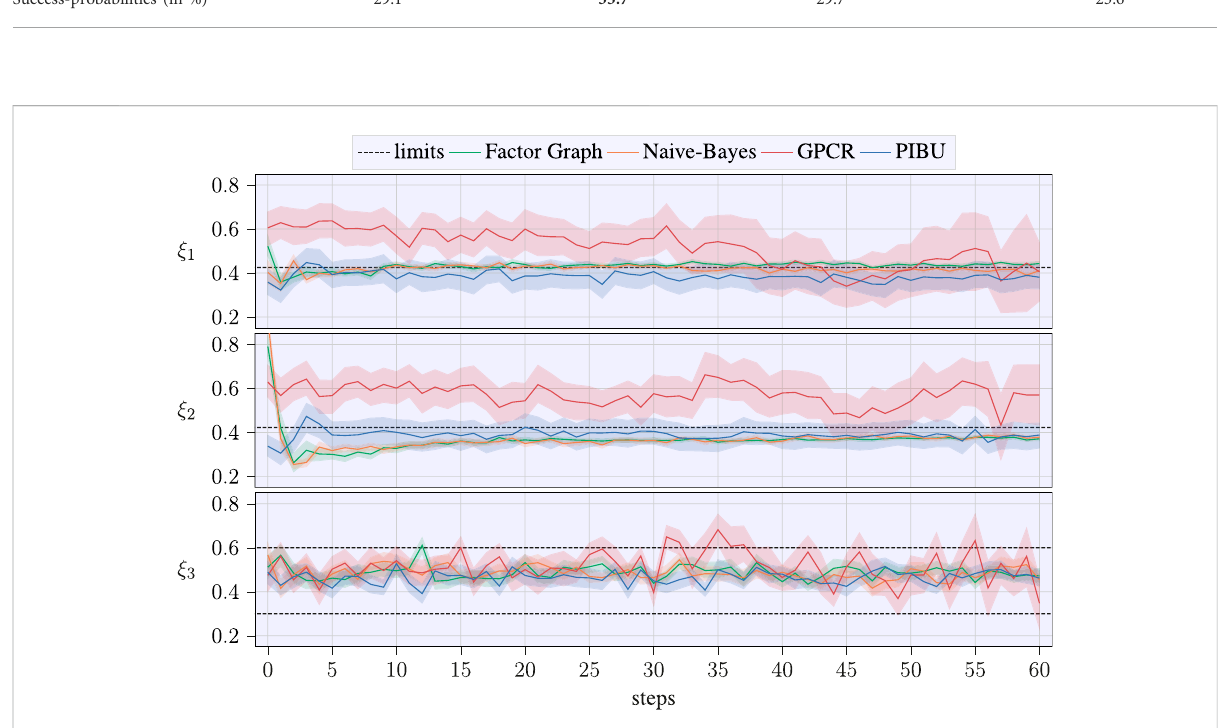
FIGURE 8 Temporal evolution of the estimated optimum parameter value, where the dashed lines denote the upper bound for the parameter, while the lower dashed line in the bottom plot denotes the dedicated lower bound. Shaded areas denote the CI of 70 %. The optimal values to be regressed from data are ξ * (cid:2) [ 0 . 421 0 . 316 0 . 495 ] ⊤